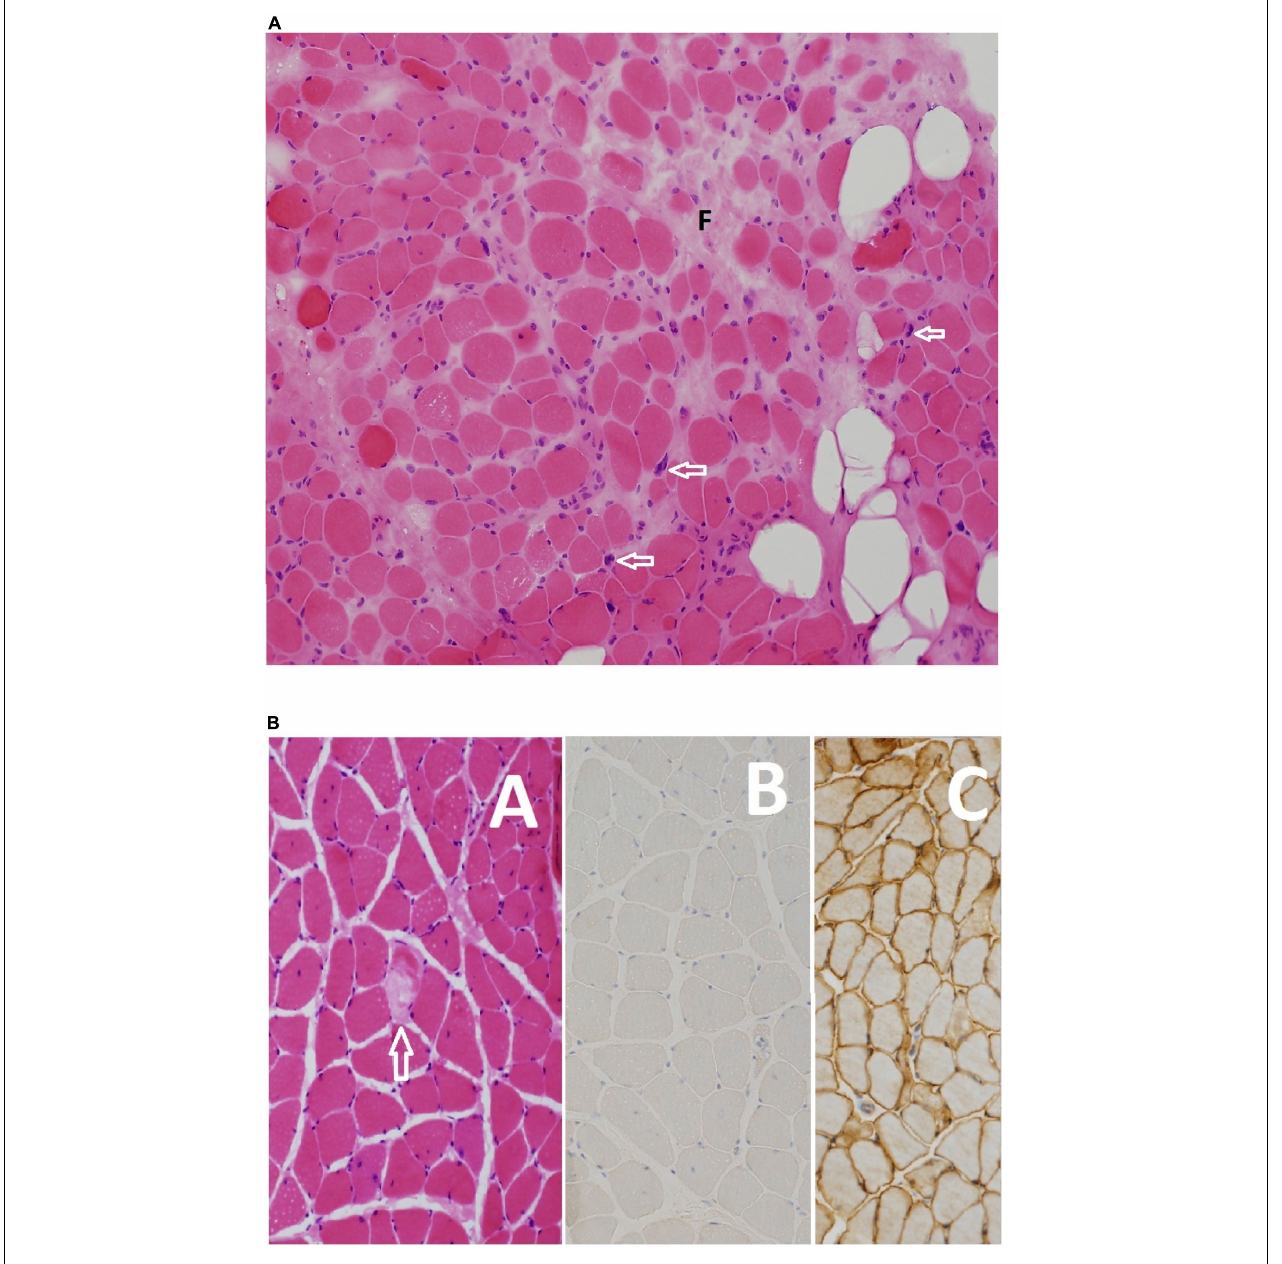
FIGURE 8 | (A) Moderate dystrophic changes manifesting with marked variation in myofiber size and fibrosis (F), and fatty infiltration (empty rounded spaces). Note also the pyknotic nuclear clumps (arrows). Myofiber necrosis and regeneration are not shown (Hematoxylin and eosin, original magnification × 200) F09 B. (B) This patient’s disease manifests with scattered necrotic fibers (arrow) among non-specific myopathic changes (A) including variation in myofiber size nuclear internalization and split fibers. Absence of expression of dysferlin confirmed the diagnosis at the light microscopy level (B) . Normal expression of healthy muscle is shown in panel (C) for comparison [ (A) Hematoxylin and eosin, original magnification × 200; (B,C) anti-dysferlin immunostain, original magnification × 200] F27 A.